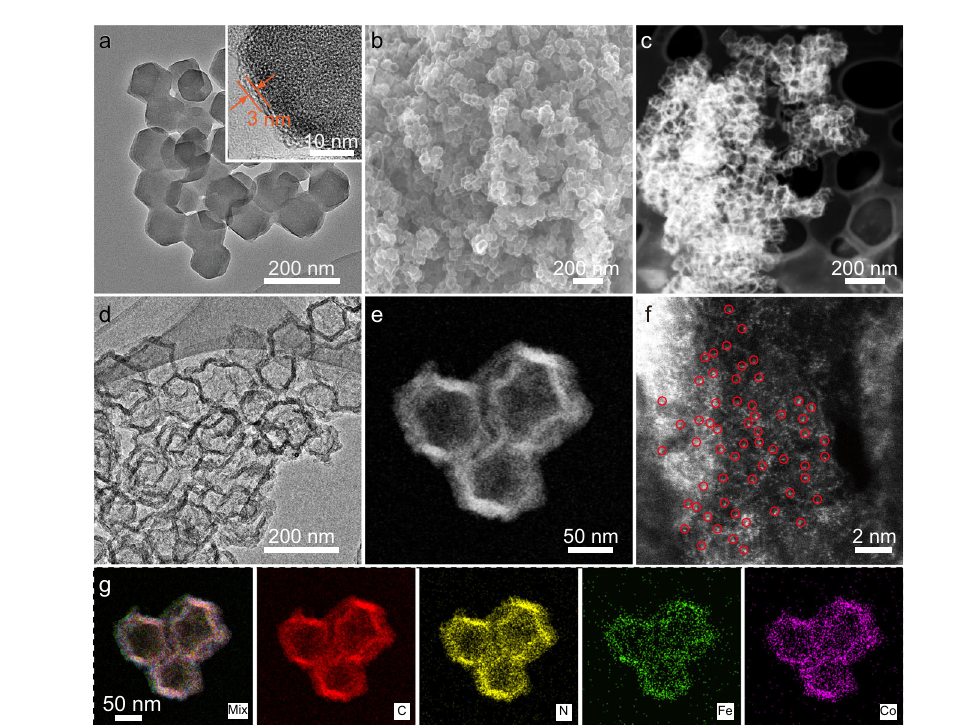
Fig. 1 | Schematic illustration of FeCo-NCH. Illustration of the typical synthesis of FeCo-NCH with atomically dispersed binary Fe/Co-N x sites in the shell.